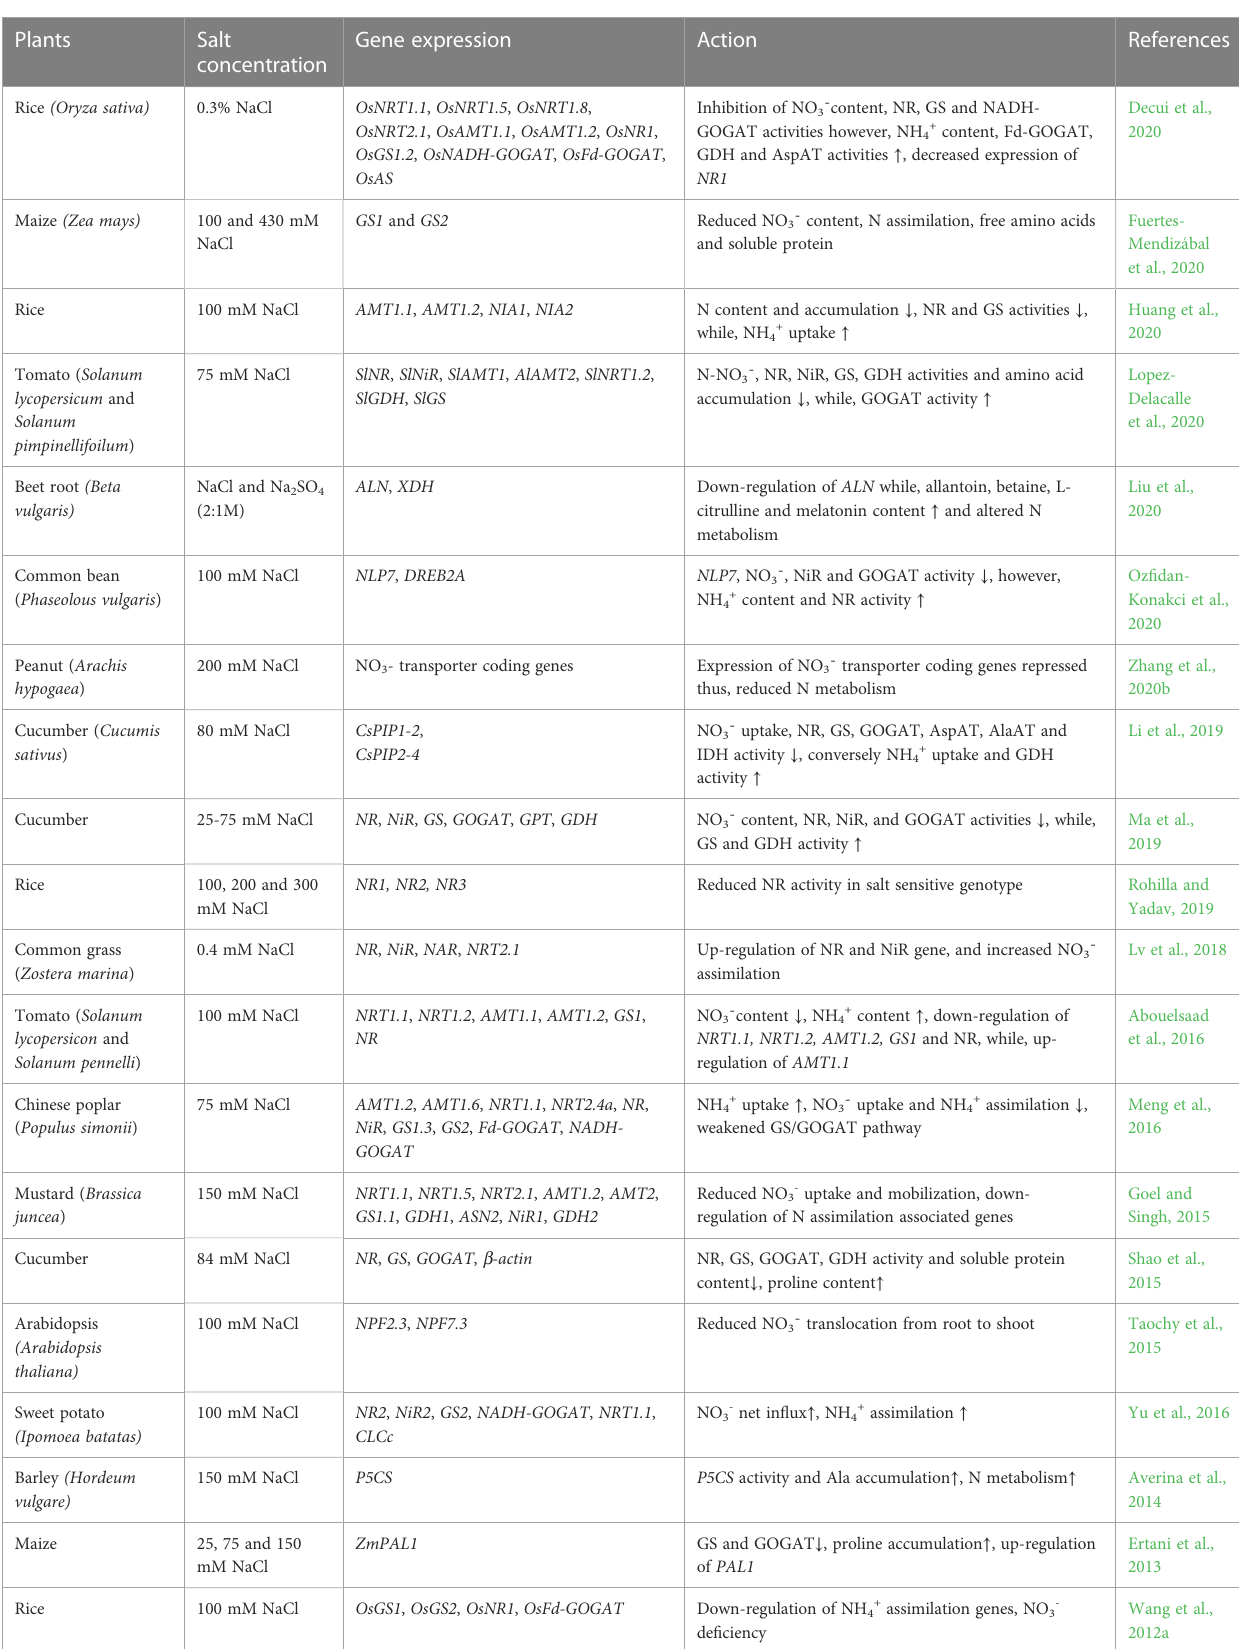
TABLE 1 Effect of salt stress on N metabolism and NUE in different plants.